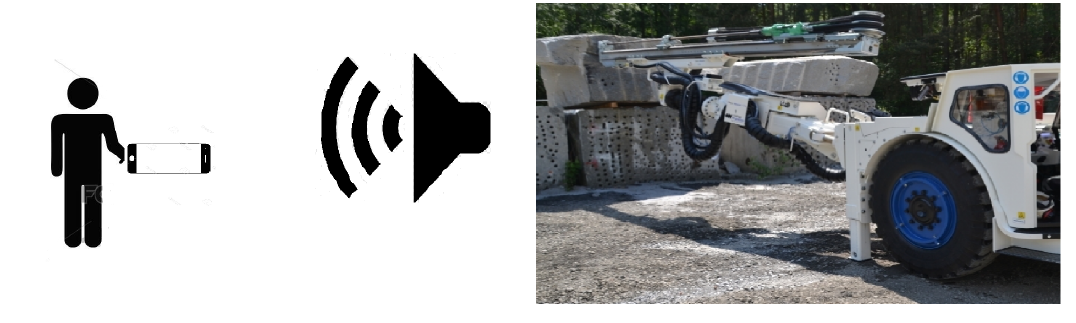
Figure 5. The concept behind acoustic data